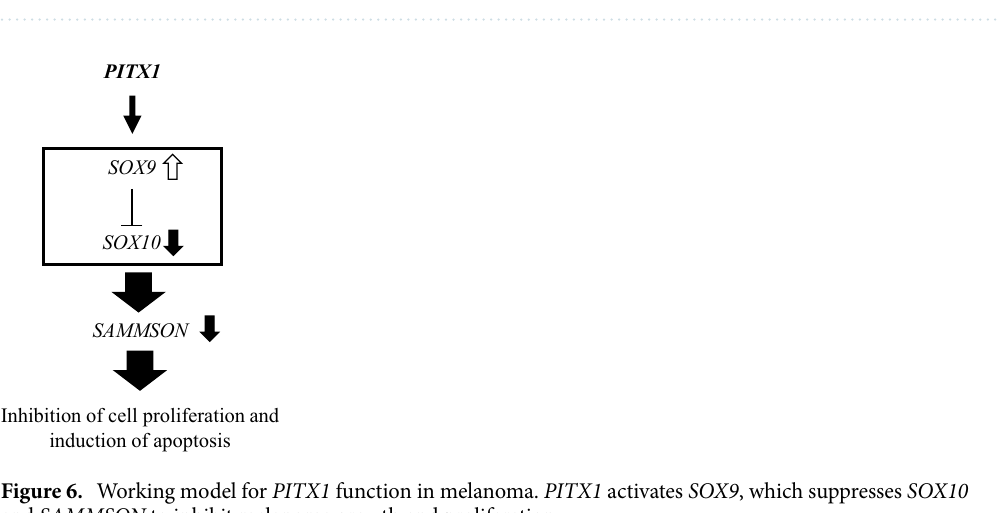
Figure 5. PITX1 inhibits tumor growth in vivo. ( A ) Photograph of subcutaneous tumors generated in Balb-c/ nu/nu mice with PITX1 transfected A2058 cells and that of the control. The left shows the control (n = 3), and the right shows PITX1 (n = 3). ( B , C ) Quantification of tumor volume and weight in PITX1 and control samples. The tumor volume curve and bar graph for tumor weight were created using Excel. ( D – H ) Immunostaining of paraffin sections of the subcutaneous tumors for PITX1, SOX9, SOX10, Ki-67 and cleaved caspase-3 (FITC: Green). DAPI staining for nuclei (blue). Merged FITC and DAPI fluorescent images are shown. Each individual channel’s image is shown in Supplementary Fig. S4. Bar graph shows the number of positive expressing cells (or relative intensity level) for each gene in the PITX1 sample compared to control. Data are presented as means ± S.D. for three independent experiments (P < 0.001). Scale bars: 100 µm. ( I ) qRT-PCR analysis of relative SAMMSON RNA expression levels in the subcutaneous tumors. Control cells were arbitrarily set as 1. GAPDH mRNA expression was used as the internal control. Data are presented as means ± S.D. for three independent experiments (P < 0.01).